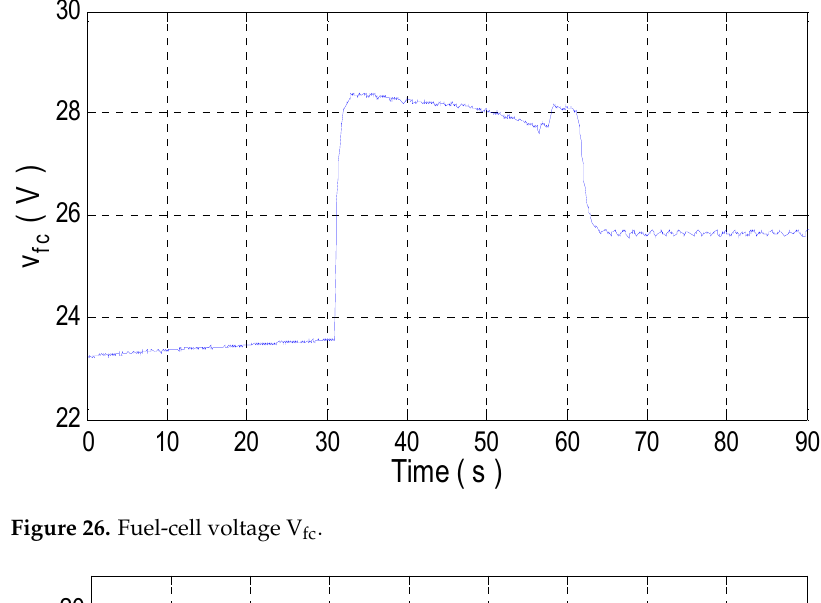
Figure 26. Fuel ‐ cell voltage V fc . Figure 26. Fuel-cell voltage V fc .